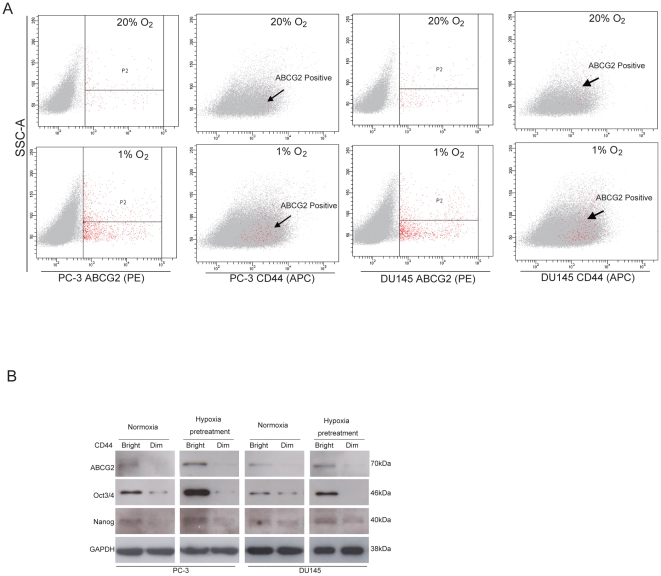
CD44bright cells are mainly positive for ABCG2, Oct3/4 and Nanog.(A) Double staining of CD44 and ABCG2 surface markers with flow cytometry assay shows higher levels expressions of these factors in both cell lines under hypoxia for 48 hours. (B) The CD44bright cells under normoxia express higher levels of ABCG2, Oct3/4 and Nanog, but the CD44dim cells under the same normoxia condition express very low levels of these factors. The CD44bright cells pretreated under 1% O2 for 48 hours show even higher levels of these factors compared to the CD44bright cells cultivated under normoxia.